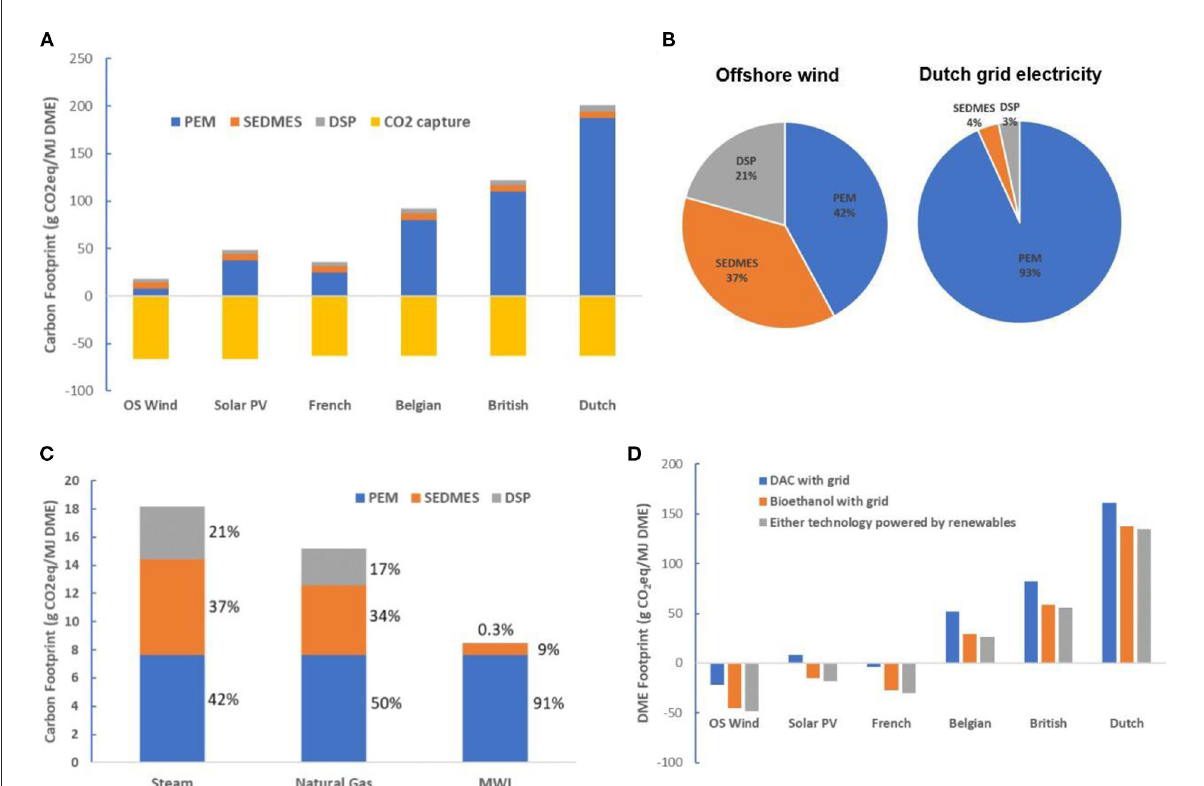
FIGURE3 (A) The carbon footprint of the DME production depending upon the electricity source: offshore wind, solar photovoltaics and French, Belgian, British and Dutch grid electricity (the four nations considered represent those within the 2 Seas region as defined by Interreg). The relative contributions of the PEM electrolysis, SEDMES and DSP processes are shown. The footprint of CO 2 capture from a bioethanol plant is provided purely for context as described in the text. (B) The relative contribution toward the DME production footprint of PEM electrolysis, SEDMES and DSP when electricity is derived from an offshore wind farm compared to the Dutch electrical grid. (C) Relative contribution toward the DME production footprint of the PEM electrolysis, SEDMES and DSP processes when the source of the heat is changed from steam produced within the chemicals industry (Steam), to natural gas to waste heat from municipal waste incineration (MWI). (D) The DME footprint, including the negative CO 2 capture footprint, when the production steps (PEM, SEDMES and DSP) are powered using different electricity sources: offshore wind, solar PV, and the four national electricity grids. The three bars each represent a different CO 2 capture option: DAC powered by European grid-average electricity; bioethanol plant flue-gas capture powered by European grid-average electricity; either DAC or bioethanol plant capture powered using renewable electricity and heat (a single bar is shown as they are almost identical when renewable power and heat are